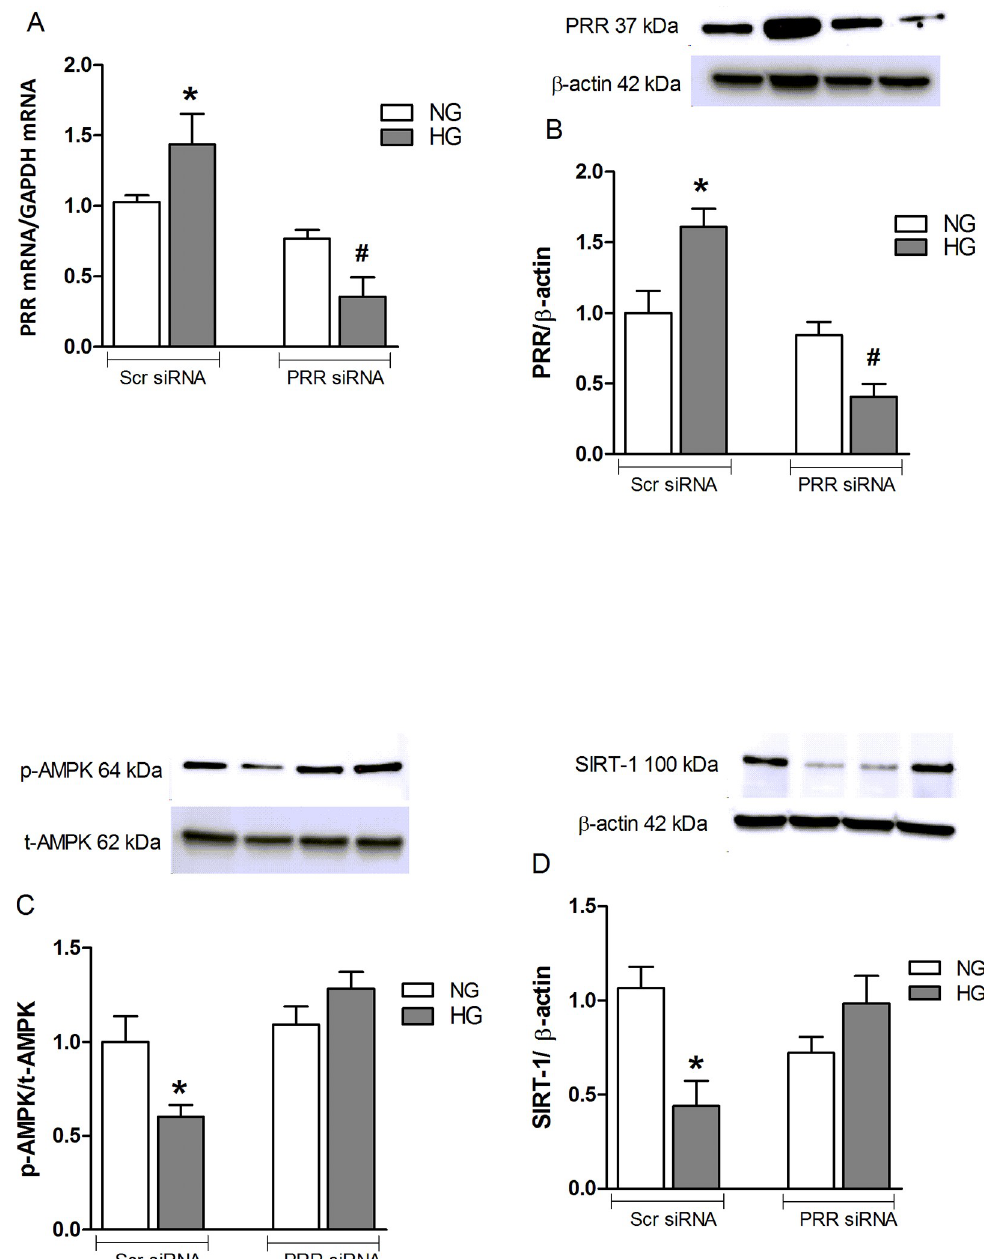
Fig 6. Pro-renin receptor (PRR) expression in mouse renal mesangial cells. (A) Pro-renin receptor (PRR) mRNA and (B) protein expression in normal glucose (NG, 25 mmol L-glucose) and high glucose (HG, 25 mmol D-glucose) cultured mRMCs treated with either scramble (Scr) siRNA or PRR siRNA. Western blot analysis of pAMPK and total AMPK protein expression (C) and SIRT-1 protein expression (D) in normal glucose and high glucose cultured mRMCs treated with either Scr siRNA or PRR siRNA (n = 6 each group). Data are mean ± SEM. � P < 0.05 vs. NG + Scr siRNA; #P < 0.05 vs. HG + Scr siRNA. n = 8 each